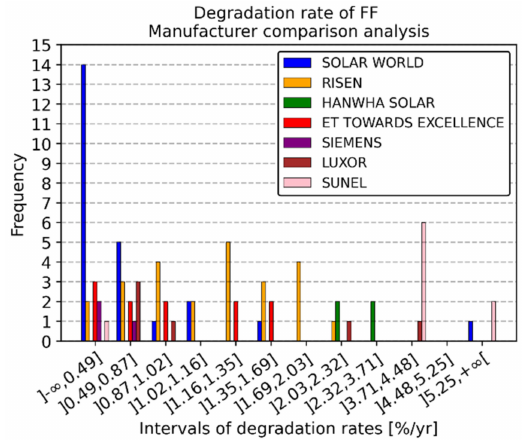
Figure 11. Manufacturer analysis of the degradation rate of the fill